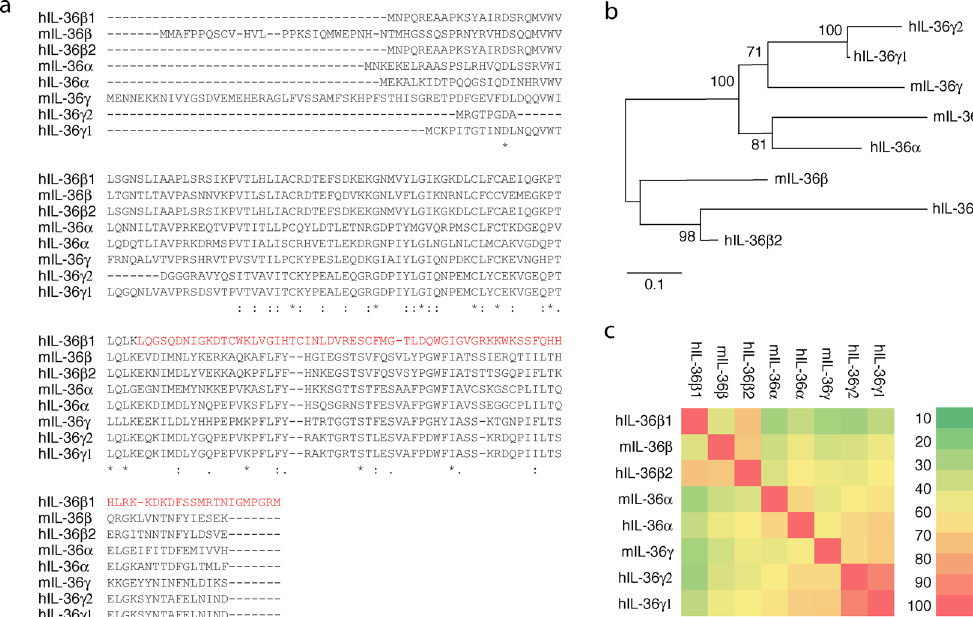
Figure 1. Protein sequence alignment of human and mouse IL-36 cytokines. ( a ) Human (h) and mouse (m) IL-36 cytokines were aligned using Clustal omega. * conserved residues: Gonnet PAM 250 matrix score > 0.5, 0 < Gonnet PAM 250 matrix score ≤ 0.5. Amino acid sequence of human IL-36 β isoform 1, which diverge from the other family members, is shown in red. ( b ) Neighbor-joining phylogenetic tree showing relationships among IL-36 cytokines. The optimal tree with the sum of branch length = 2.69 is shown. The percentage of replicate trees in which the associated taxa clustered together in the bootstrap test (1000 replicates) are shown next to the branches. The tree is drawn to scale, with branch lengths in the same units as those of the evolutionary distances used to infer the phylogenetic tree. The evolutionary distances were computed using the Poisson correction method and are in the units of the number of amino acid substitutions per site. ( c ) Heat map showing percentage similarity between the human and mouse IL-36